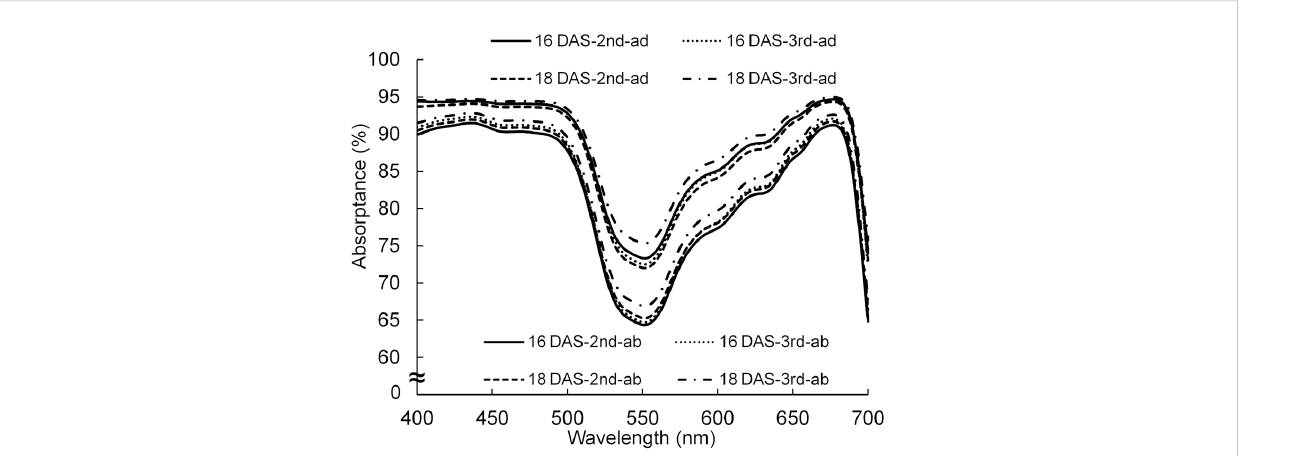
FIGURE 11 The spectral distributions of absorptance of adaxial (ad) and abaxial (ab) surfaces of the 2nd and 3rd leaves of komatsuna 16 DAS and 18 DAS ( n = 10). The spectral distributions were calculated from the spectral distributions of re fl ectance and transmittance measured by a spectrophotometer (V- 750, JASCO Corporation, Tokyo, Japan) with an integrating sphere (ISV-922, JASCO Corporation, Tokyo, Japan). The spectral distributions of absorptance of the komatsuna leaves in the other leaf positions in 18 DAS were similar to those of the 2nd and 3rd leaves of komatsuna 18